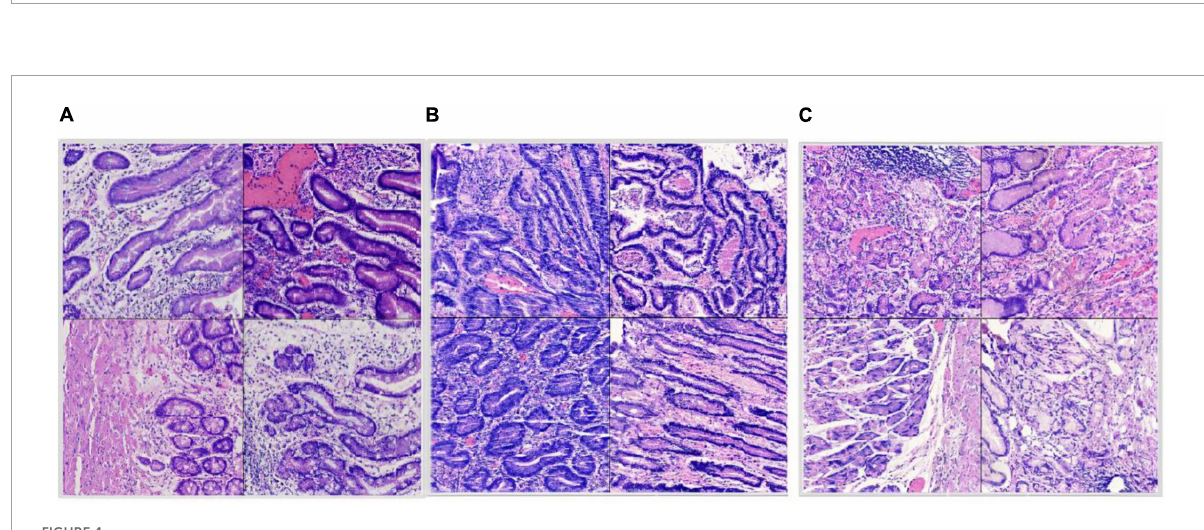
FIGURE4 Split dataset: (A) Intestinal metaplasia region patches; (B) cancerous region patches; (C) normal region